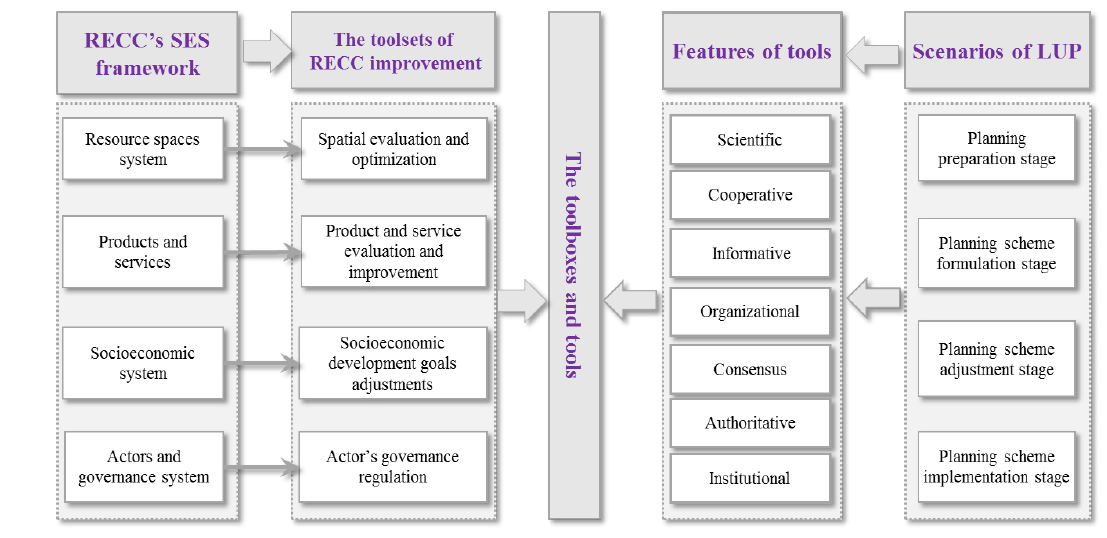
Figure 5. The framework of RECC improvement tools based on LUP. Table 2. RECC improvement tools in LUP.